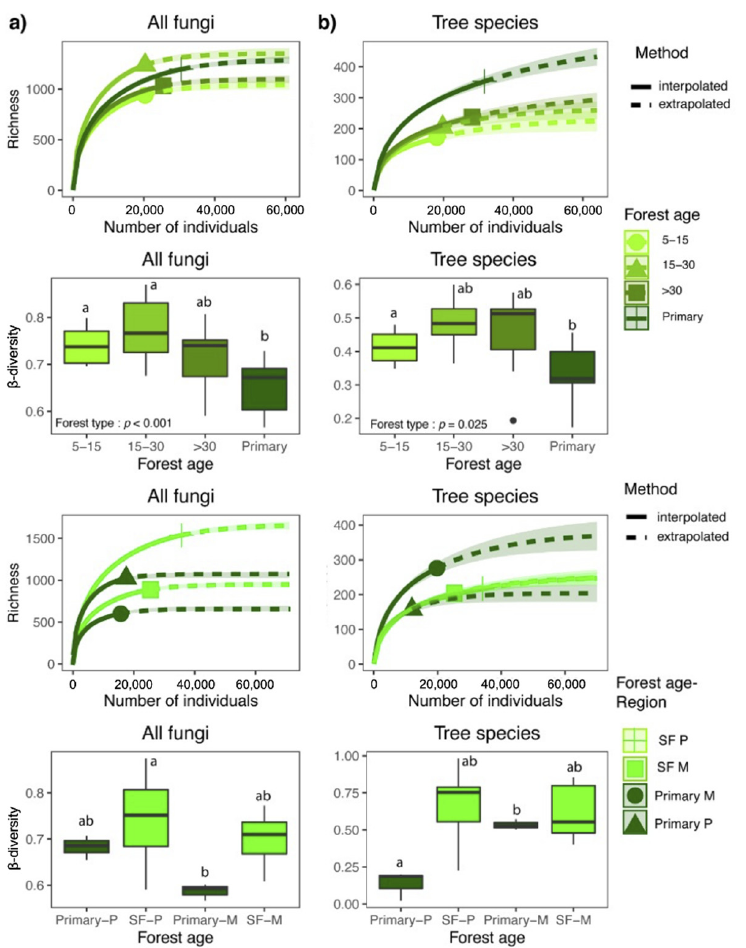
Figure 1. ( a ) Hill’s N0 interpolated and extrapolated richness across different stand age classes. Unbroken and dashed parts of the curve denote interpolated and extrapolated values, respectively, and the shaded zone around each curve denotes the 95% confidence intervals. Comparison of compositional turnover ( β -diversity) of fungal and tree communities of early- (5–15 y), mid- (15–30 y), and late-successional (> 30 y) and primary forests based on normalized matrices. ( b ) Hill’s N0 interpolated and extrapolated richness across different stand age classes and compositional turnover ( β -diversity) of fungal and tree communities in secondary forests (SF) and primary forests and between geographic regions, Piro (P) and Mogos (M). β -diversity was calculated as an abundance- based Jaccard similarity index. Means were compared using ANOVA and Tukey’s HSD tests, with letters denoting significant differences within each